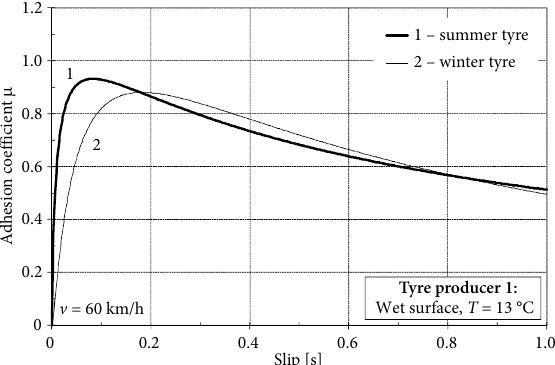
Figure 9. Velocity characteristics: comparison of summer and winter tyres